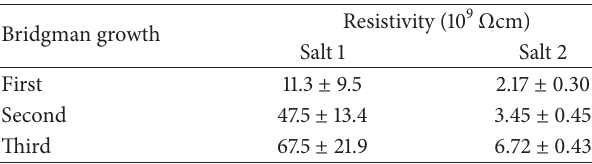
Table 3: Resistivity values for TlBr detectors prepared from the crystal grown once, twice, and three times by the repeated Bridgman method. The samples used are from crystal middle region. Bridgman